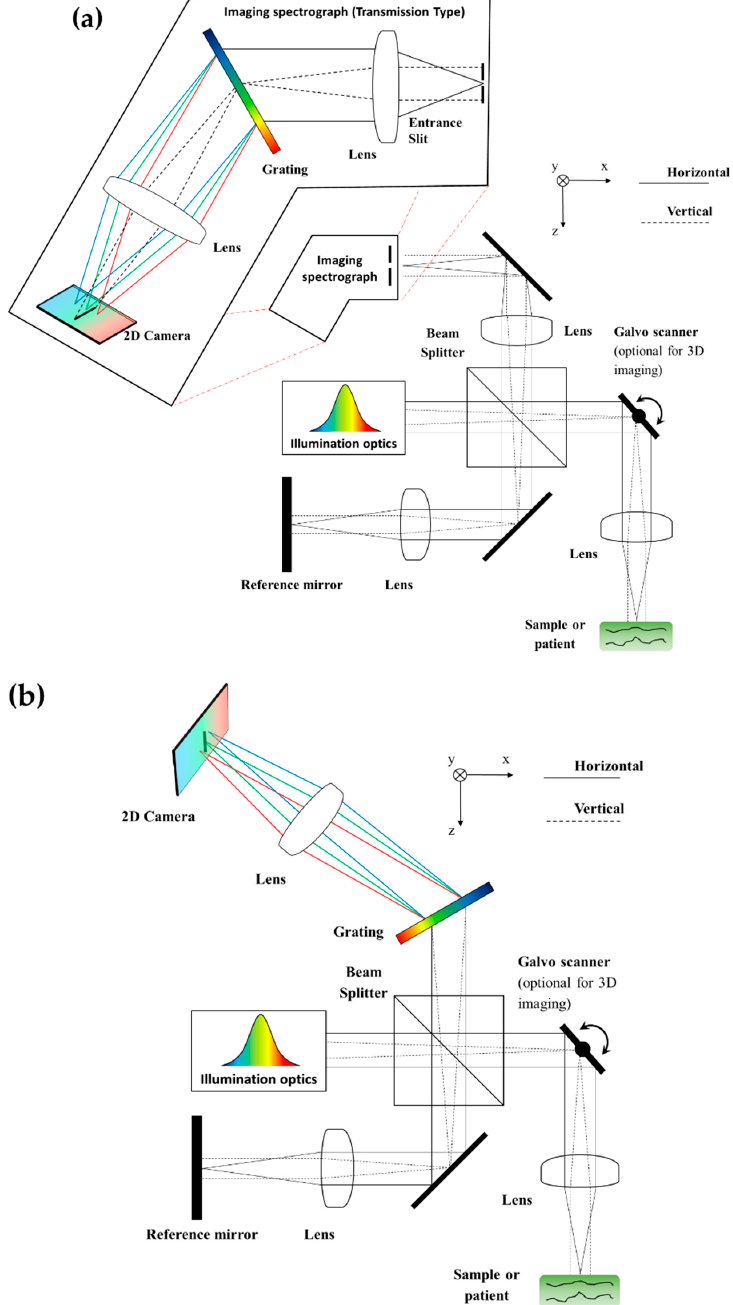
Figure 5. Schematic diagram of generic ( a ) slited and ( b ) slit-less LF SD OCT systems.